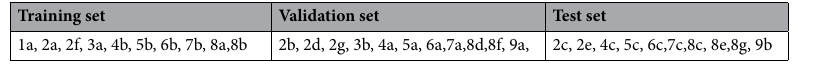
Table 2. Date sets.